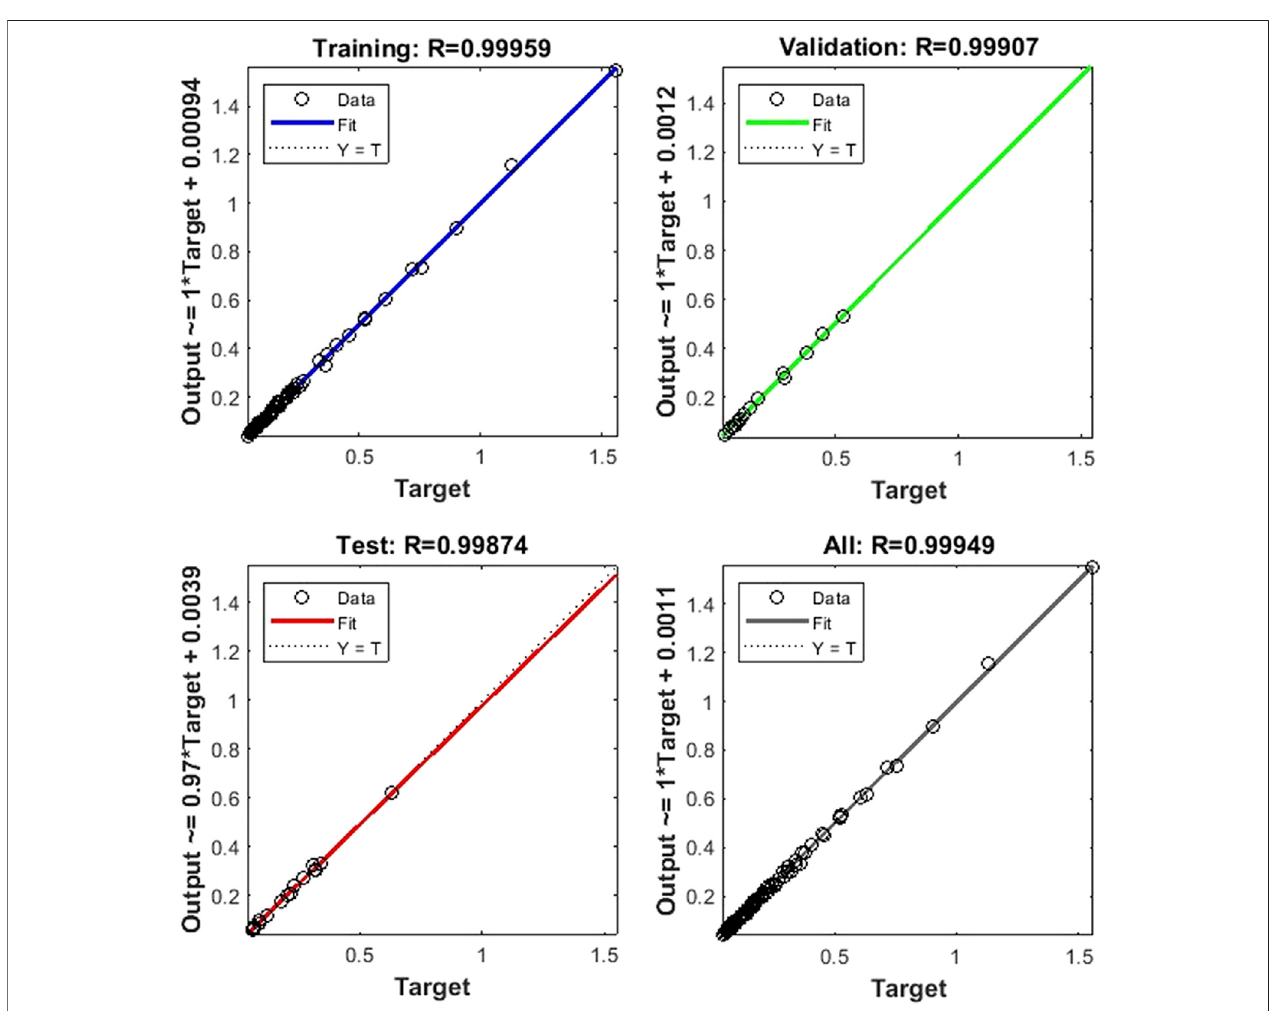
FIGURE 5 | Fitting curve of time-dependent leukocyte transmigration